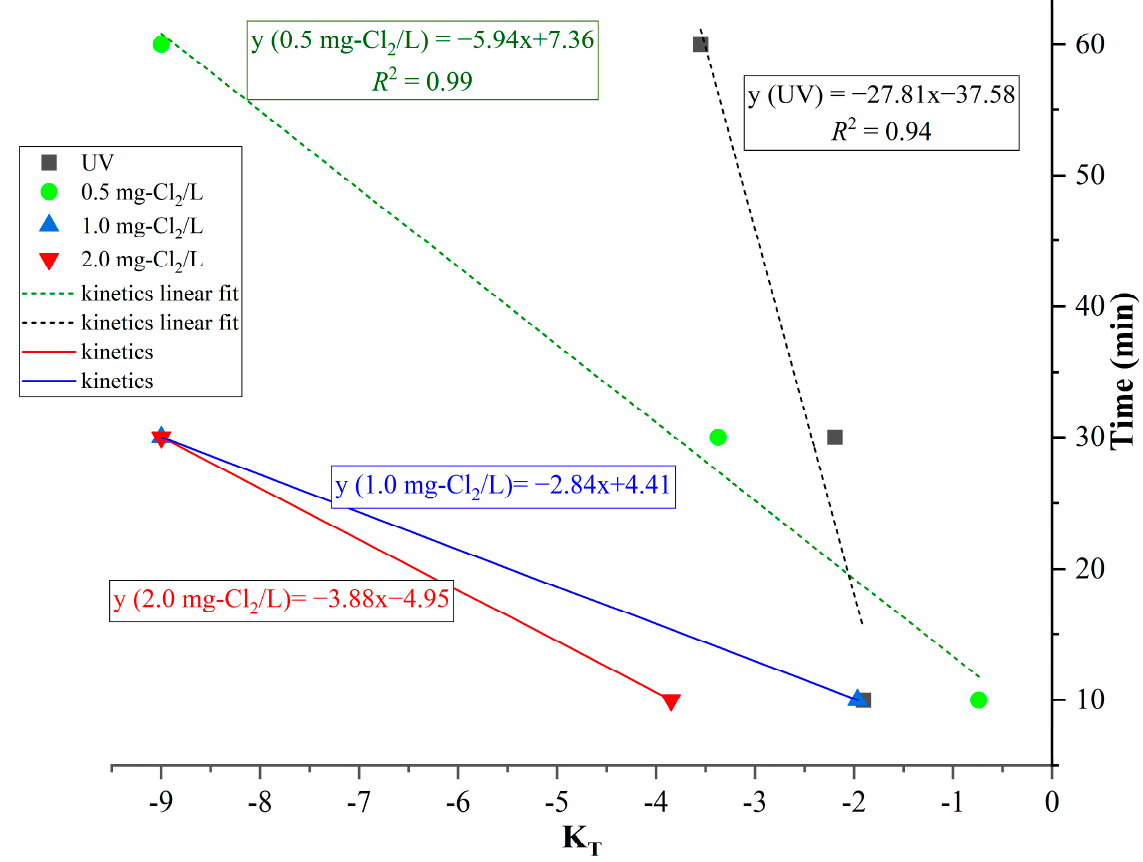
Figure 4. Kinetics of transformation efficiency affected by UV and 0.5, 1.0, and 2.0 mg-Cl 2 /L treat- ments. Table 2. Processing time required to reduce the 2-log 10 transformation efficiency.